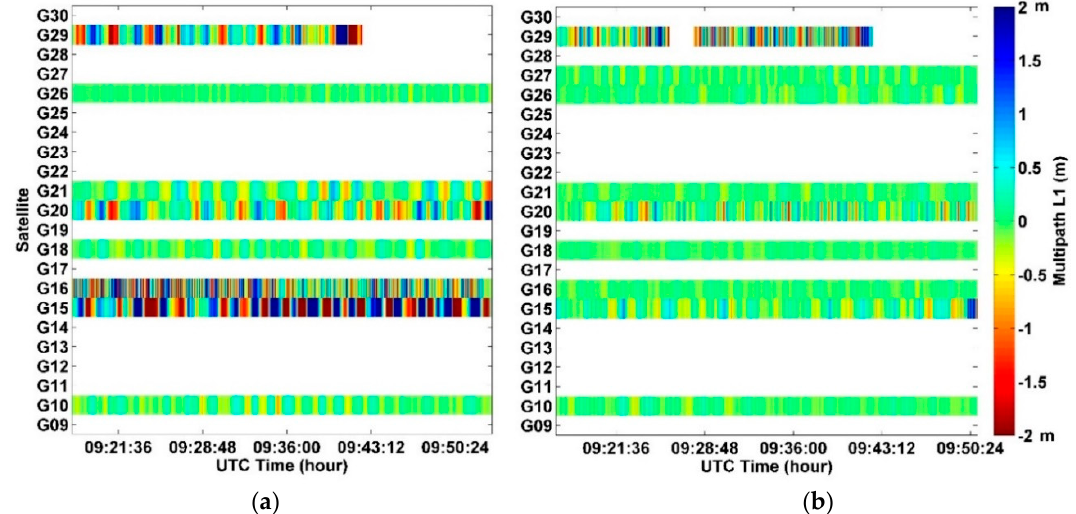
Figure 5. L1 multipath satellite-specific patterns for the rover ( a ) and base station ( b ).